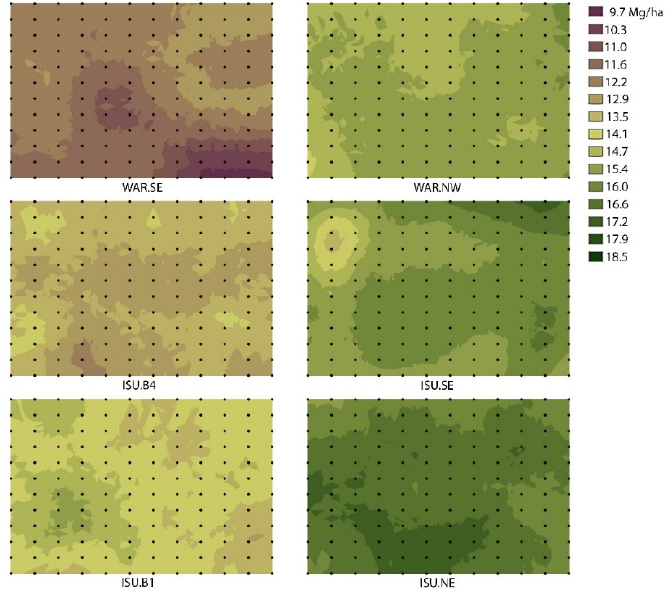
Figure 3. Interpolated yield maps for six maize uniformity trials conducted from 2015–2016 to evaluate the natural variability among field plots of varying size. A total of 144 experimental units were arranged in a 12 × 12 grid with individual plots measuring 3.0 m wide × 4.6 m long. Maps were created using the kriging interpolation Spatial Analyst tool of ArcMap 10.8 (ESRI, Redlands, CA, USA). A spherical semivariogram model was used with the ordinary kriging method for the interpolation. Smith’s index of soil heterogeneity ranged from 0.532 to 1.026 among the six trials (Table